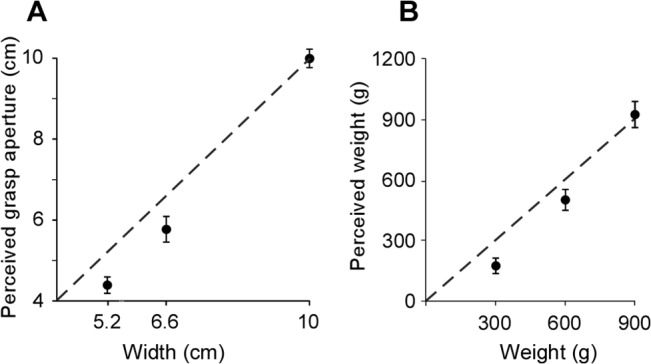
Relationship between actual and perceived grasp aperture (experiment 1), and actual and perceived weight (experiment 2).A, the relationship between actual and perceived grasp aperture for the three canisters of the same weight (600 g) but different width (5.2, 6.6, 10 cm). Data are presented as mean [95%CI]. Actual and perceived grasp aperture were linearly related with a mean R
2 value of 0.99 [0.99 ‒ 1.00]. The dashed line is the line of identity. On average, grasp aperture was underestimated. B, the relationship between actual and perceived canister weight for the three canisters of the same width (6.6 cm) but different weight (300, 600, 900 g). Actual and perceived weight were linearly related with a mean R
2 value of 0.98 [0.97 ‒ 0.99]. Data are presented as mean [95% CI] and the dashed line is the line of identity. On average, canister weight was underestimated.